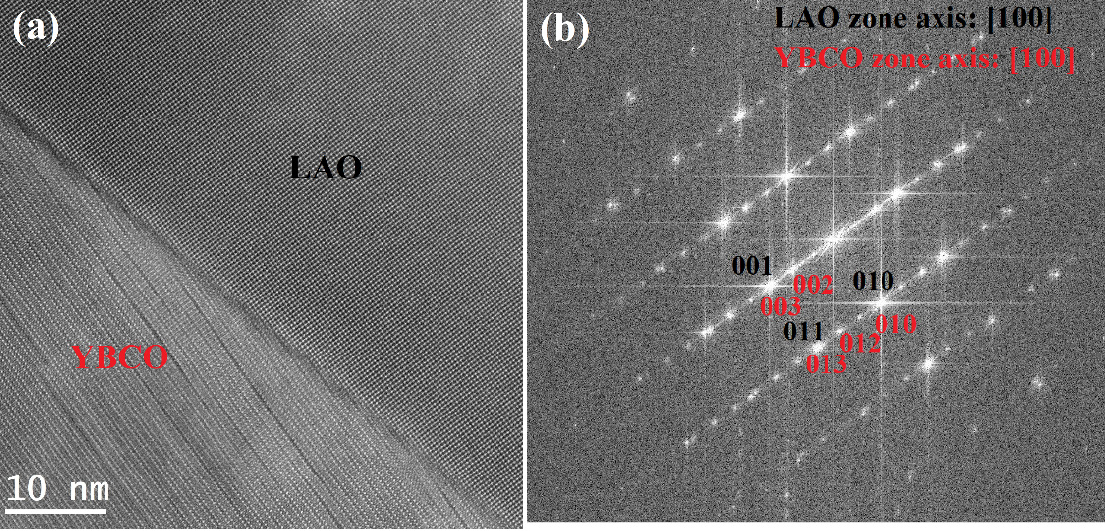
Figure 3. ( a ) HRTEM image of YBCO thin film on 15° vicinal cut LAO and ( b ) the corresponding FFT pattern.